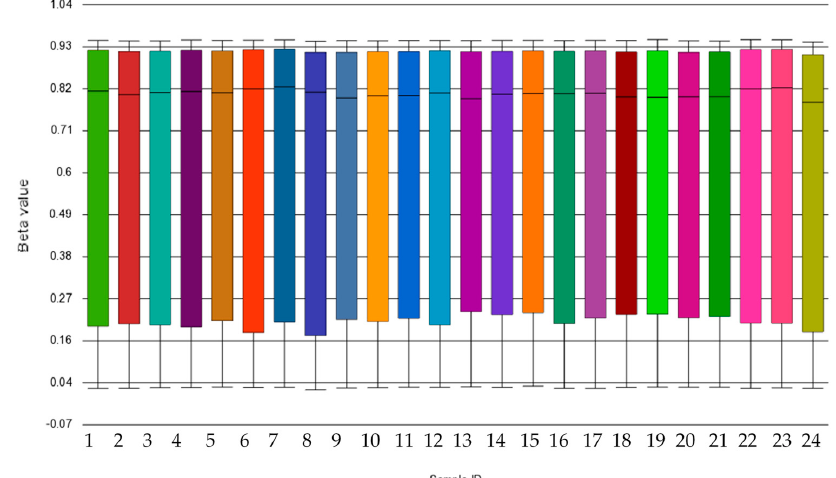
Figure 1. Box and whisker plots of β -values. Each box represents a sample ( n = 24) which is illustrated by a different color bar. The median β -value is 0.042 with a minimum and maximum range of 0.785 and 0.827.